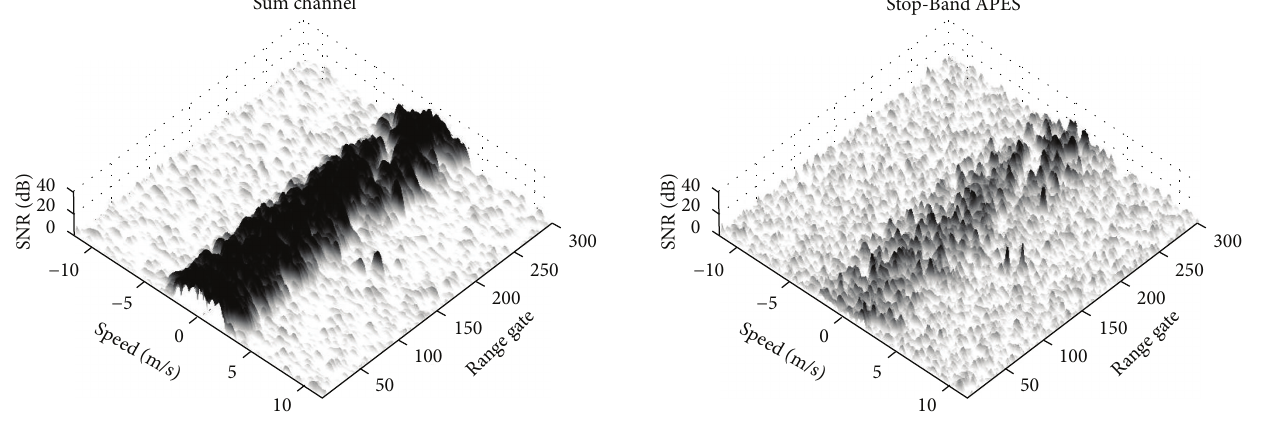
Figure 9: Range-Doppler map showing the sum channel of the RAMSES data.